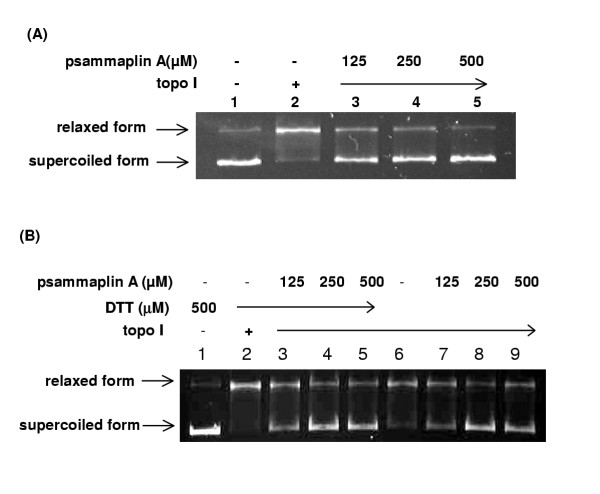
Psammaplin A inhibited topo I catalytic activity. Topo I activity was measured by the relaxation of superhelical plasmid DNA. The assay mixture (20 μl) contained pUC118 (20 μg/ml), topo I (1 unit), and various amounts of the psammaplin A. After 30 min at 30°C, the reactions were stopped by the addition of 5 μl of stop solution. The samples were then loaded onto the agarose gel (0.8%) for electrophoresis followed by photography. (A) The reaction mixtures contain 0.5 mM DTT; (B) Compare the reactions in the presence and absence of 0.5 mM DTT.